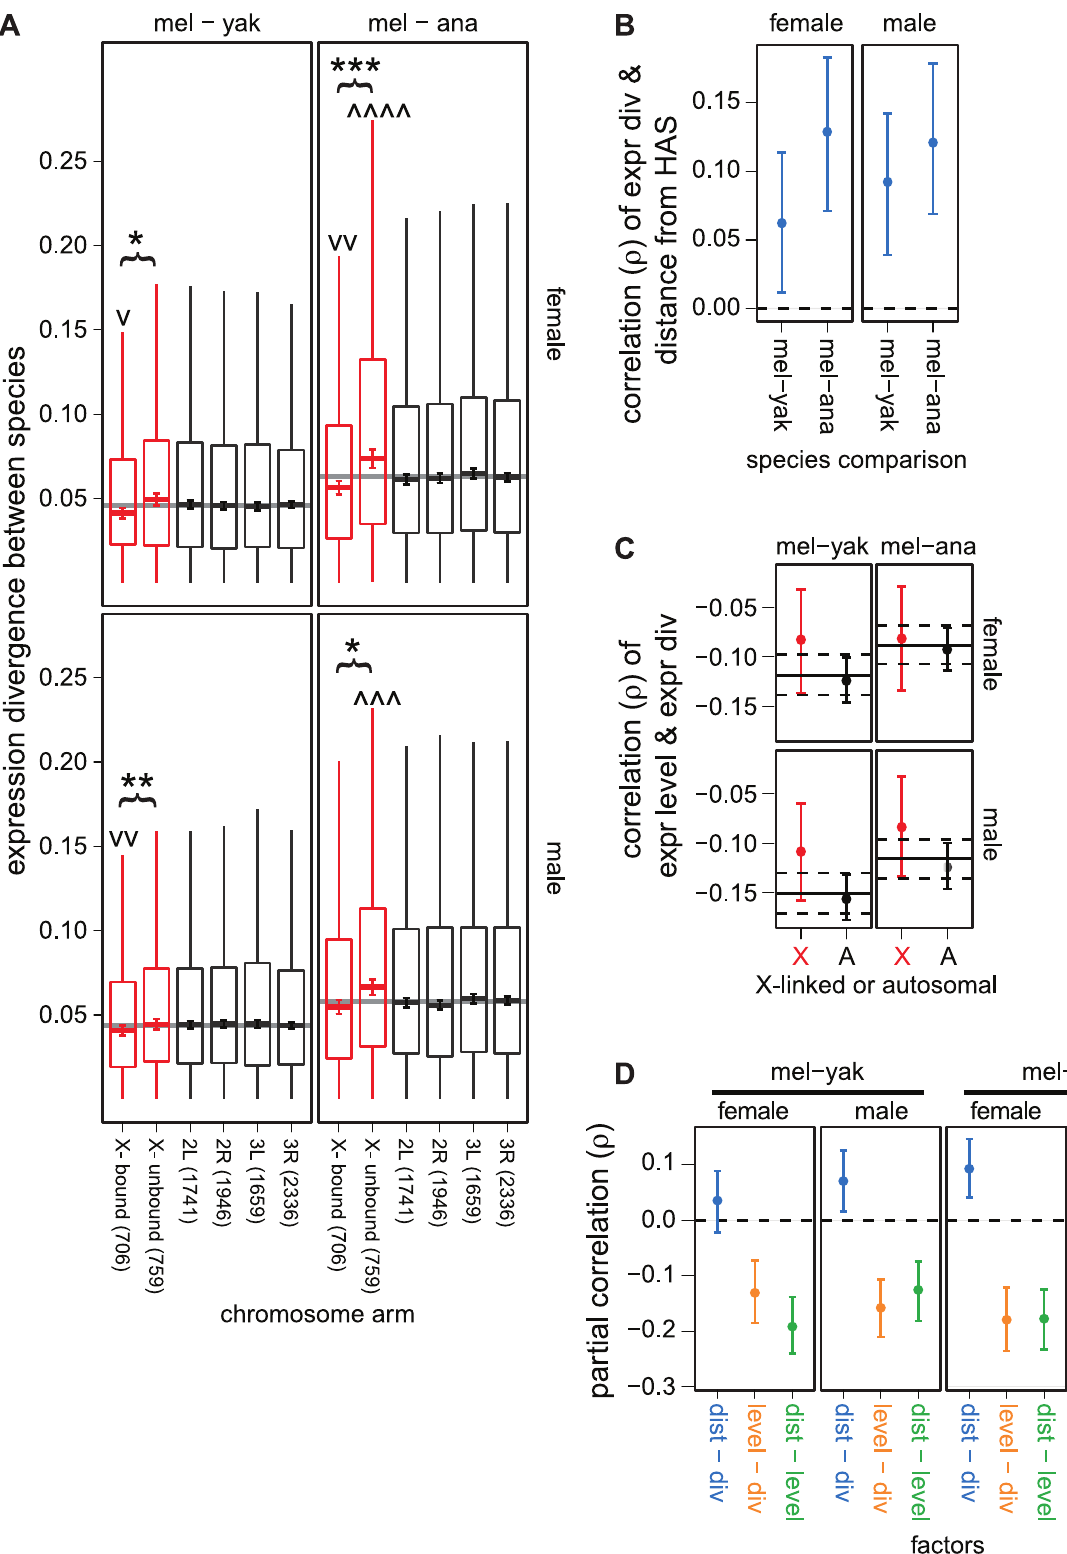
Figure 5. Faster expression evolution of X-linked genes not directly regulated by the DCC. (A) Boxplots show the pairwise divergence in expression between 1:1:1 orthologs in the D. melanogaster (mel), D. yakuba (yak), and D. ananassae (ana) genomes measured in whole females (top) and males (bottom) on each chromosome arm. X-linked genes are divided into those that are bound and unbound by the DCC. The counts of genes on each chromosome and DCC bound and unbound genes are given along the x-axis. Boxes extend from the first to the third quartile (interquartile